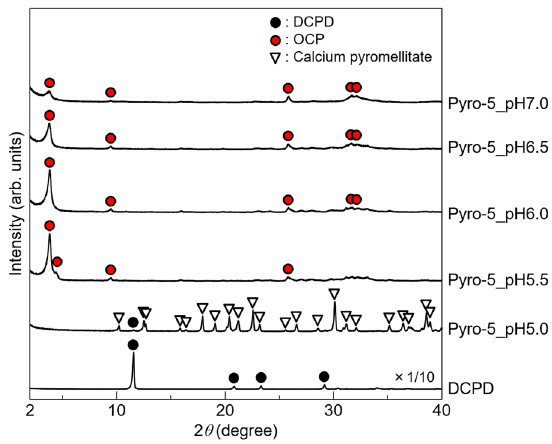
Fig. 3 XRD analysis. Powder XRD patterns of the samples synthesised hydrolytically from DCPD in a 200 mol m − 3 acetate buffer solution containing 5 mol m − 3 of pyromellitic acid with an initial pH ranging from 5.0 to 7.0. The XRD pattern of DCPD is shown at one-tenth of its actual intensity.